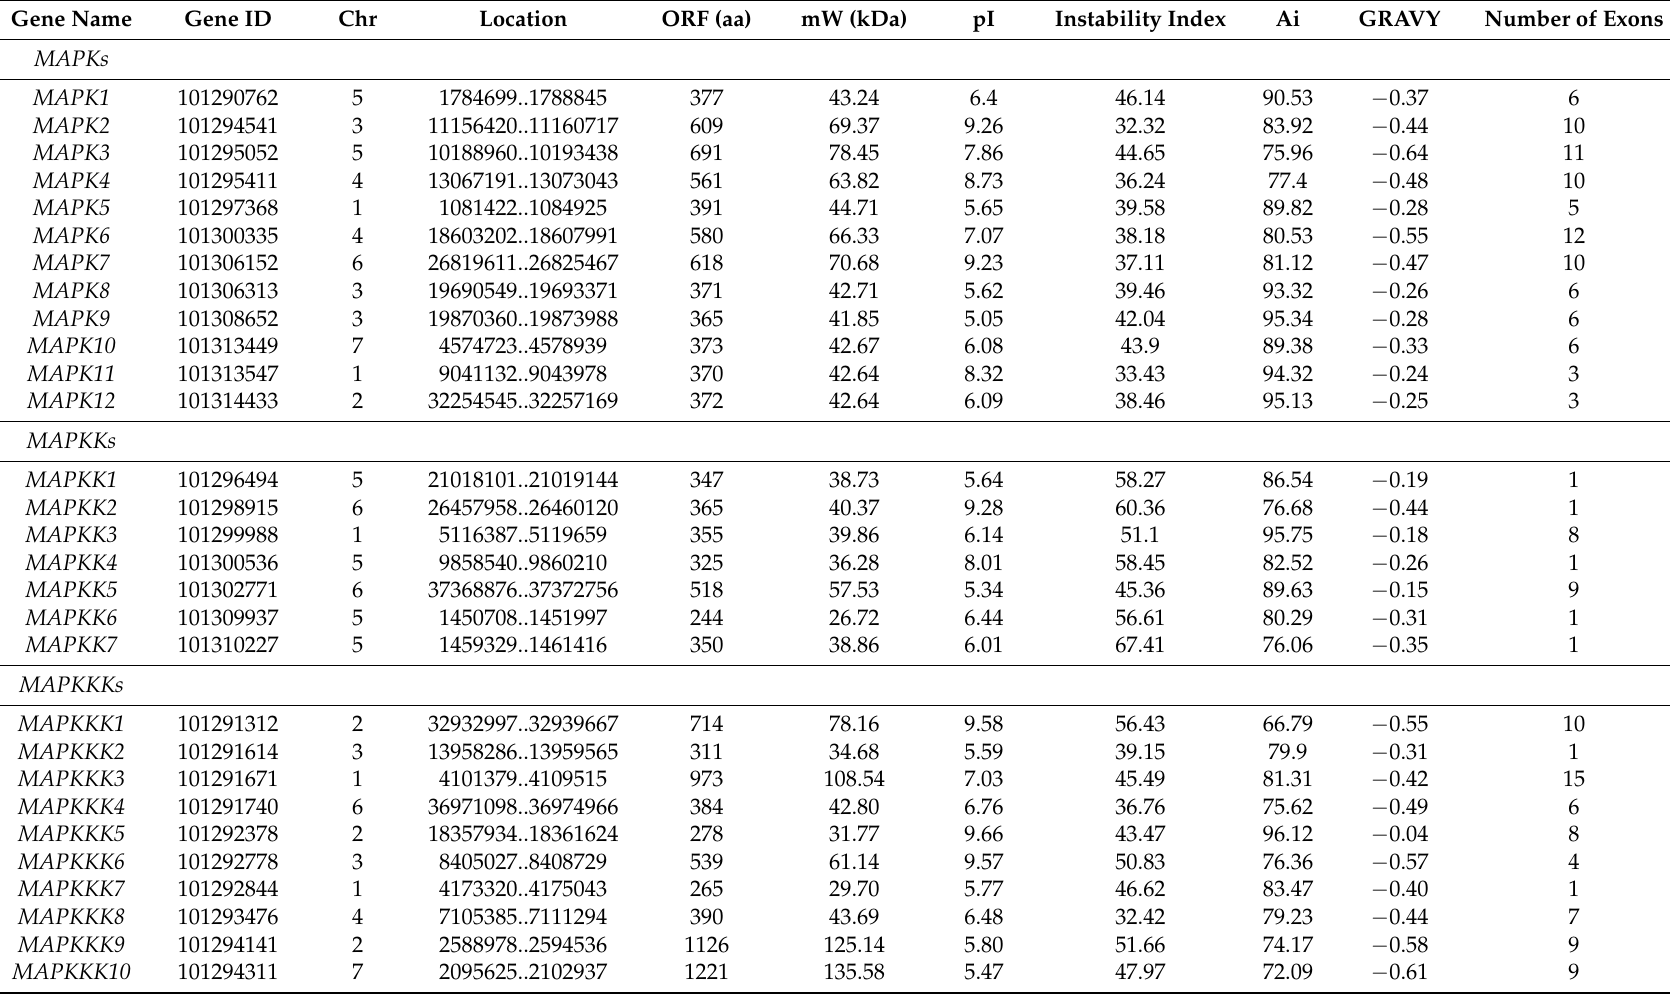
Table 1. MAPK cascade proteins identified in the Fragaria vesca